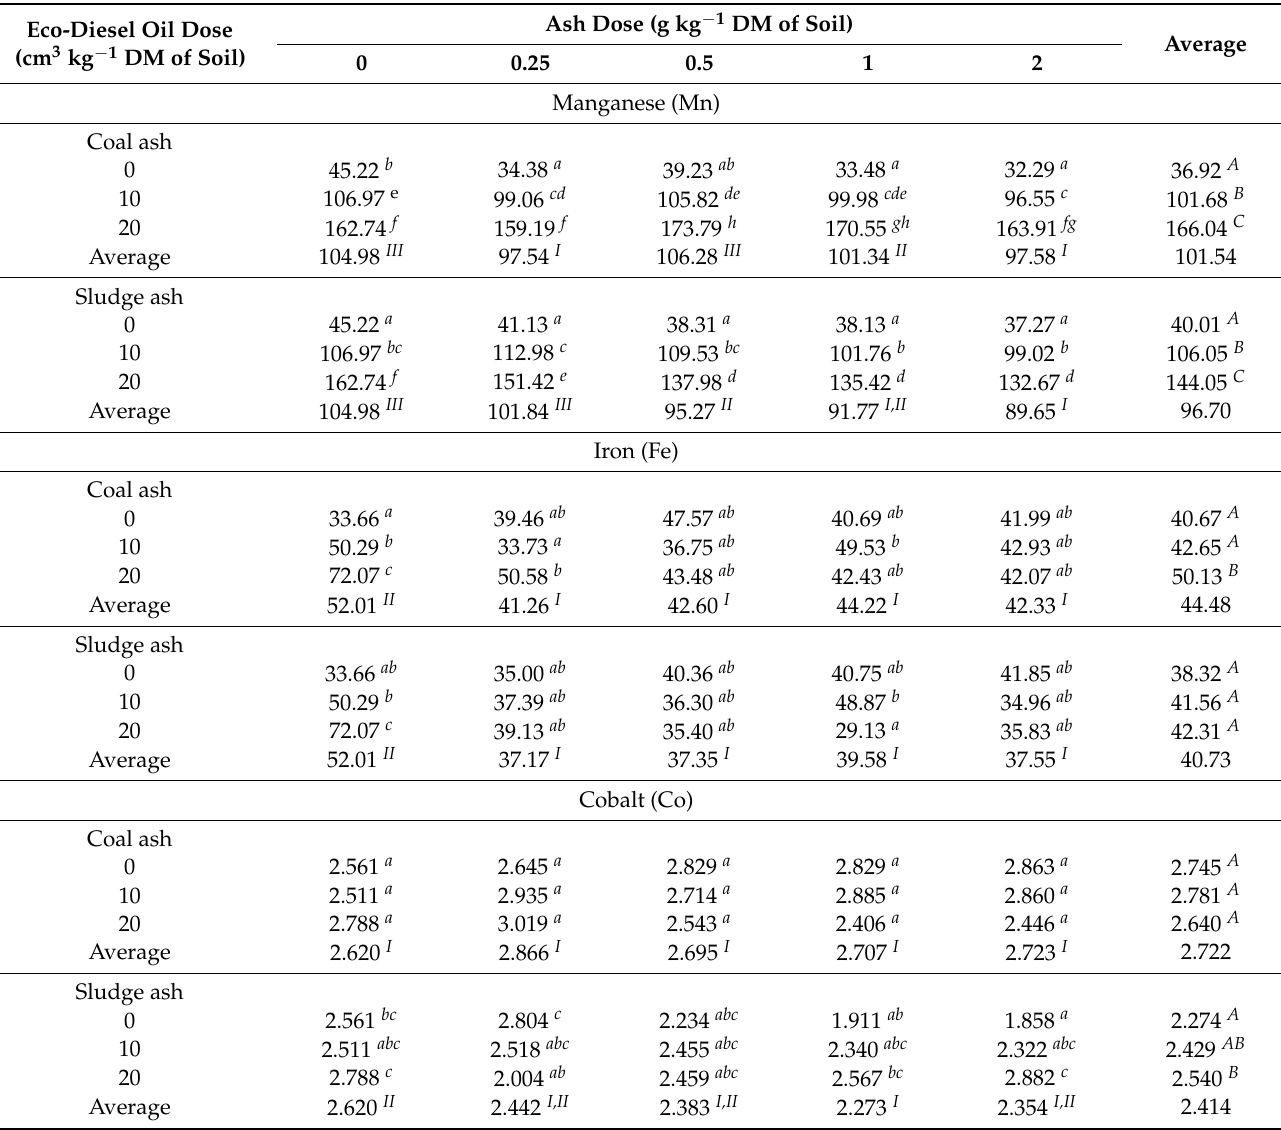
Table 3. Content of manganese (Mn), iron (Fe), and cobalt (Co) in above-ground parts of maize— Zea mays L. (mg kg − 1